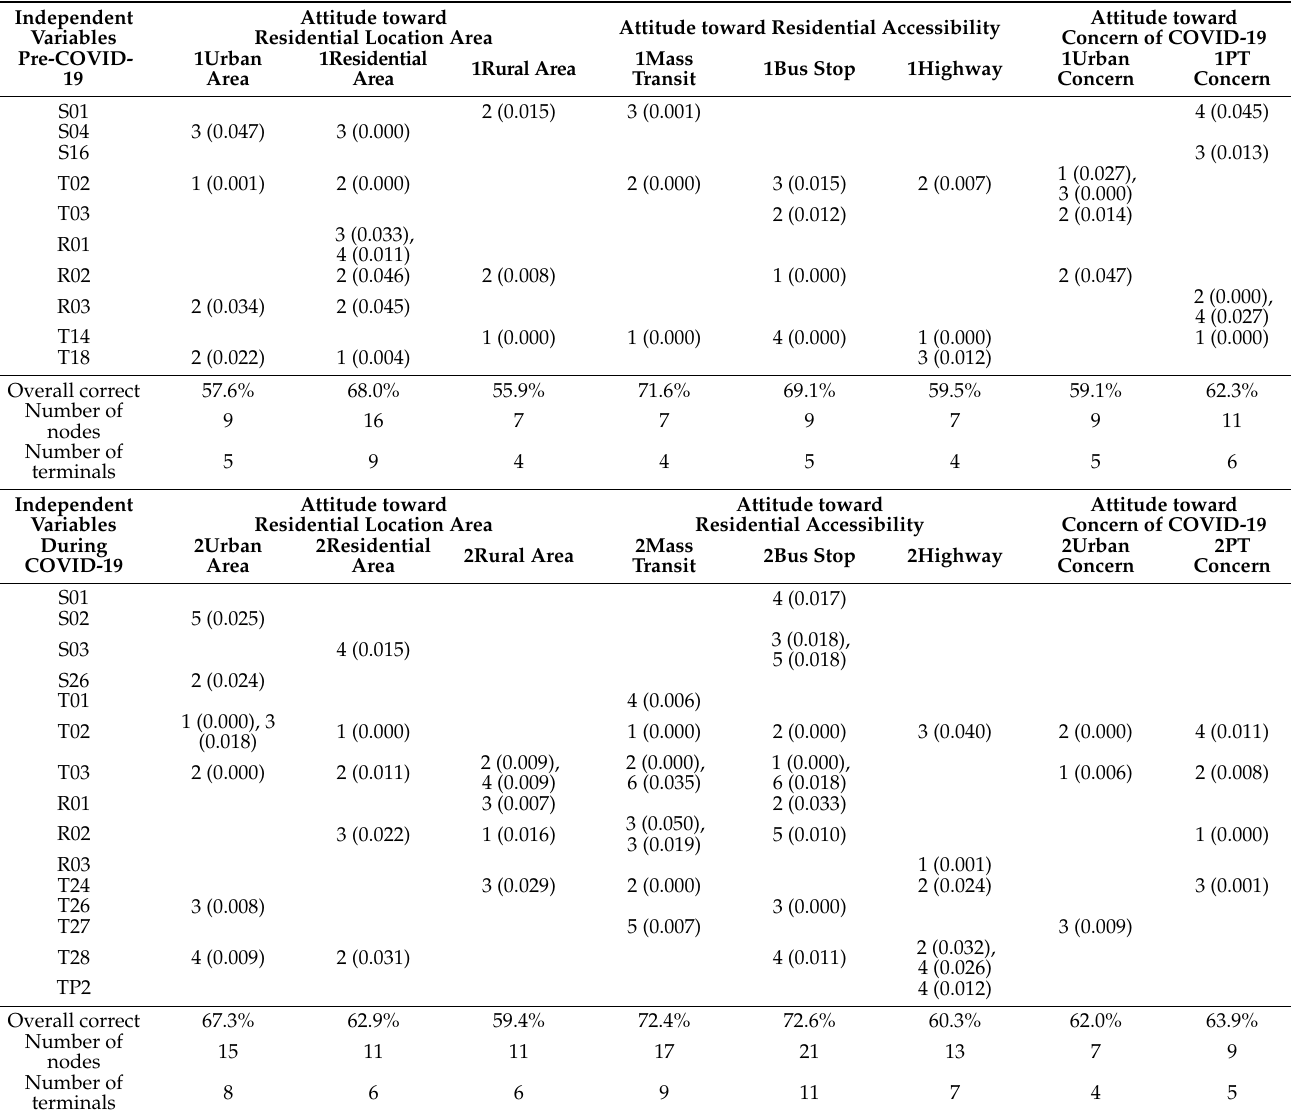
Table 9. Summary of the node level and p -value of relevant variables on